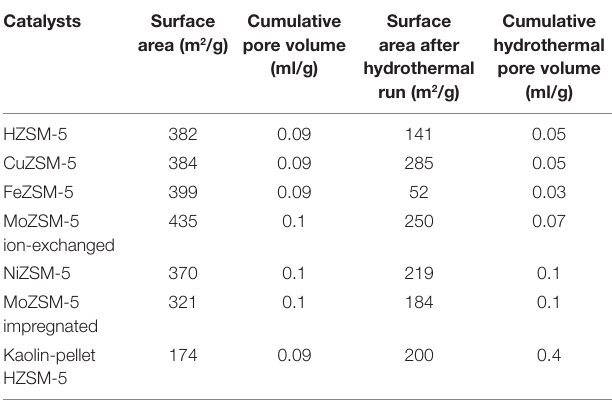
TaBle 1 | BeT values calculated for fresh and used doped hZsM-5; pore volume and desorption calculated by the BJh methods. catalysts